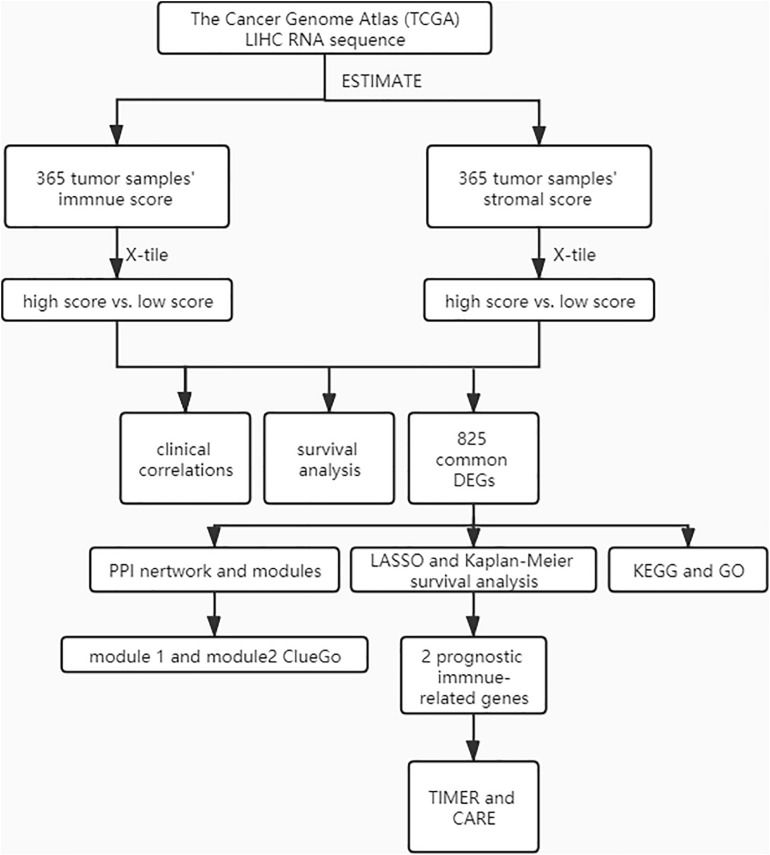
The general pipeline of the data analysis protocol.